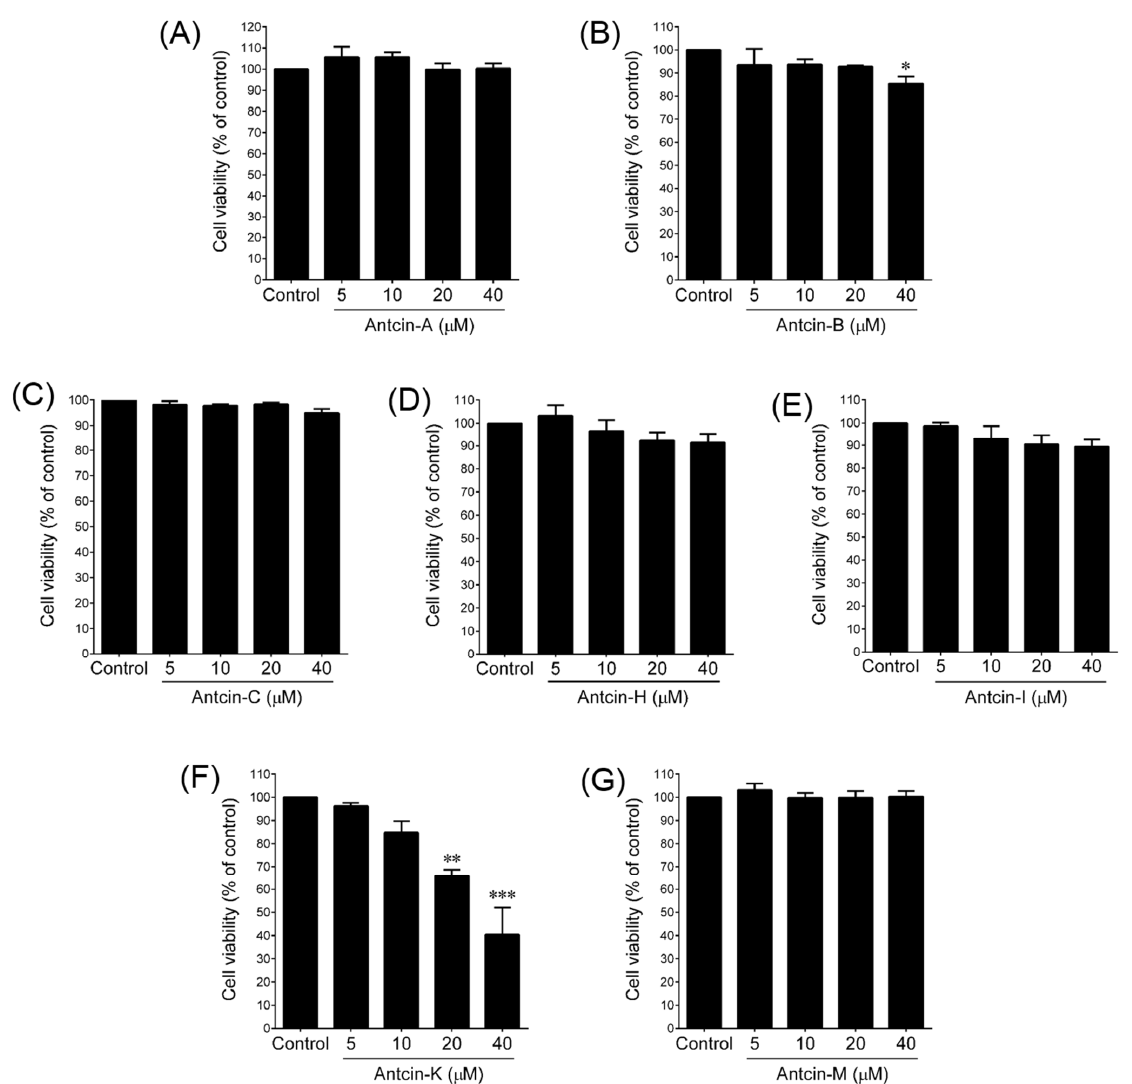
Figure 2. Cytotoxic effects of antcins on HT-29 cells. ( A–G ) HT-29 cells were incubated with increasing concentrations of antcins (5–40 M) for 48 h. The cell viability was determined by the MTT colorimetric assay as described in materials and methods. Values represent the mean ± SD of three independent experiments. p -values of less than 0.05 *, 0.01 **, and 0.001 *** were considered statistically significant for the antcins treatment group vs . the control group.